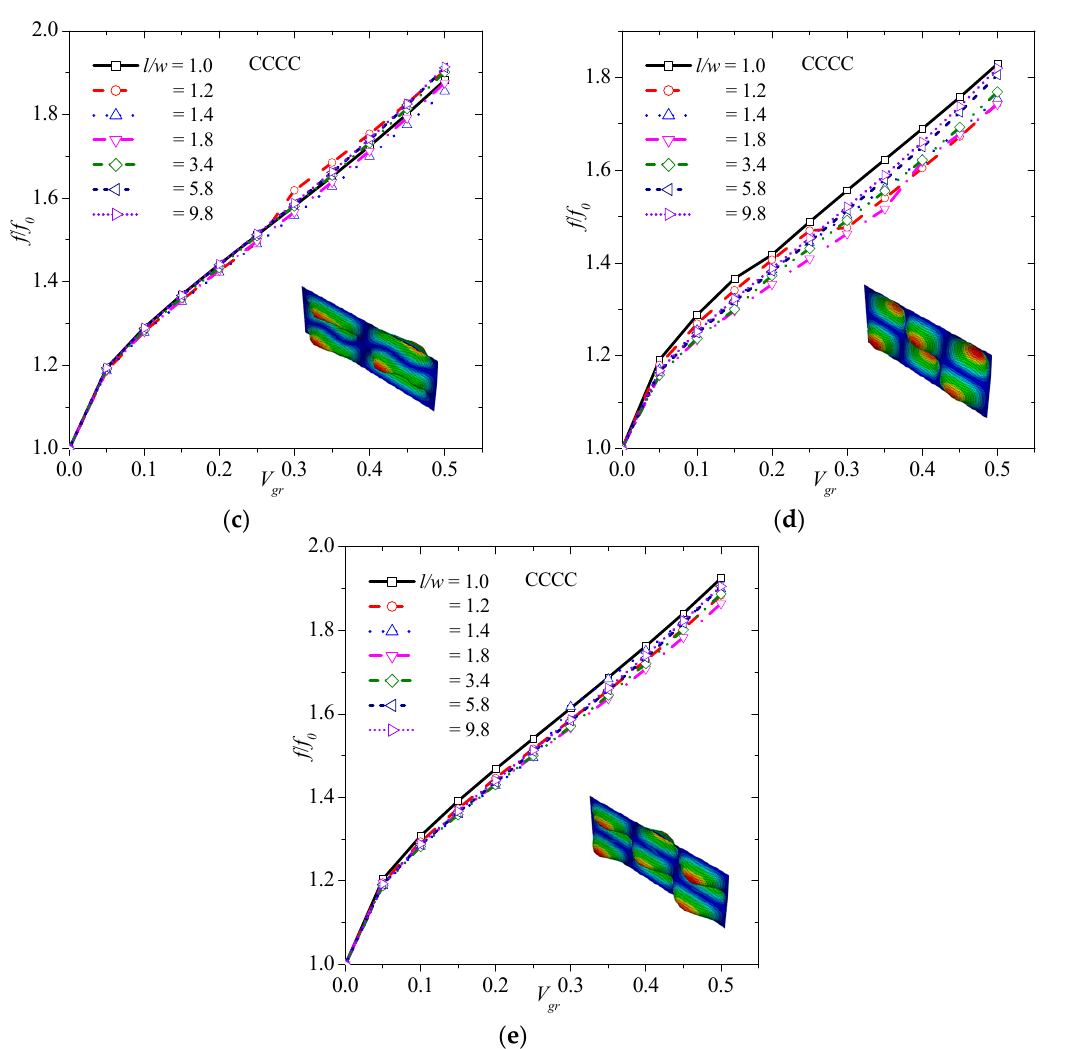
Figure 5. Normalized frequency versus volume fraction of graphene considering ( a ) (1,3), ( b ) (3,1), ( c ) (2,3), ( d ) (3,2), and ( e ) (3,3) vibration mode for CCCC boundary condition.